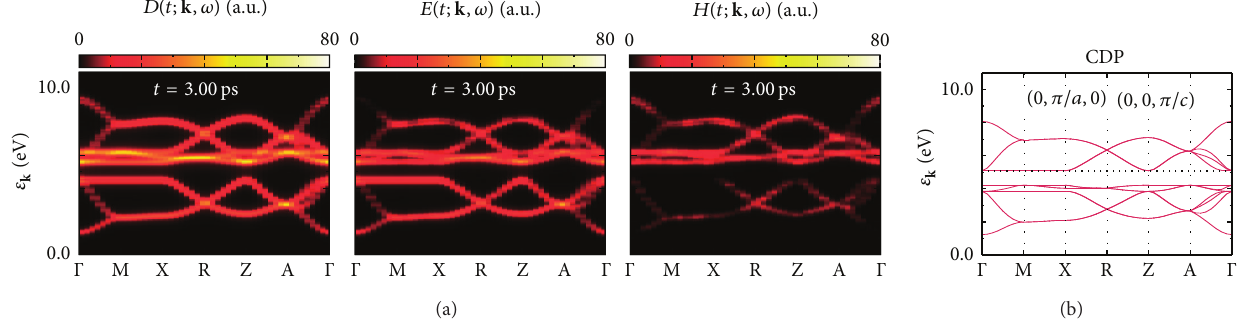
Figure 9: (a) The one-particle spectral functions 𝐷(𝑡; k ,𝜔) , 𝐸(𝑡; k ,𝜔) , and 𝐻(𝑡; k ,𝜔) at 𝑡 = 3.00 ps in the case of A 0 ‖ a in Figure 6. (b) A band structure of the CDP state labeled ∘ in Figure 3. The Fermi energy 𝜀